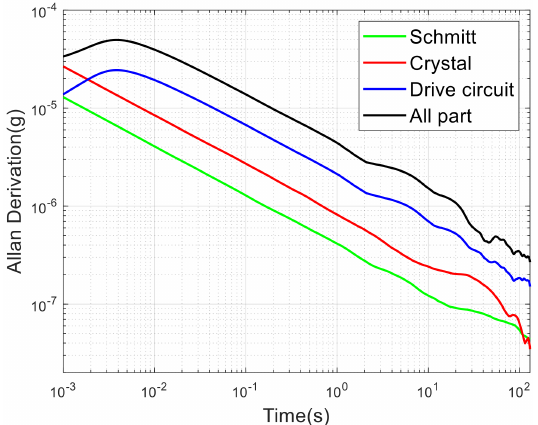
Figure 16. Allan deviation in x-axis and y-axis by simulation.